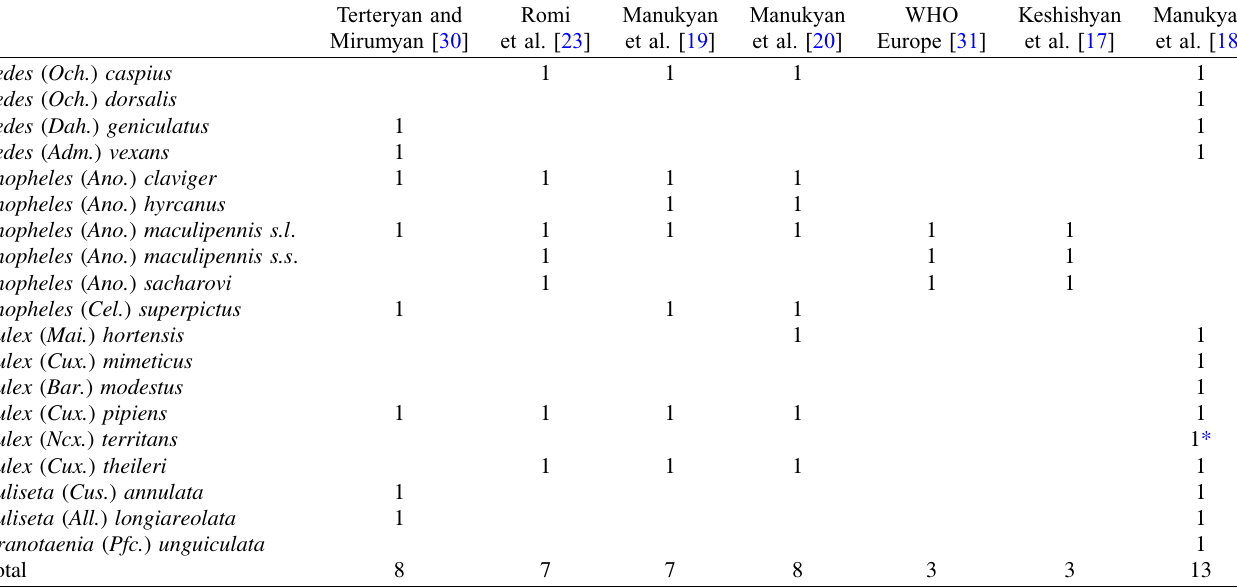
Table 1. Mosquito species/taxa reported to occur in Armenia in the literature, prior to 2016 (1 = presence record). Terteryan